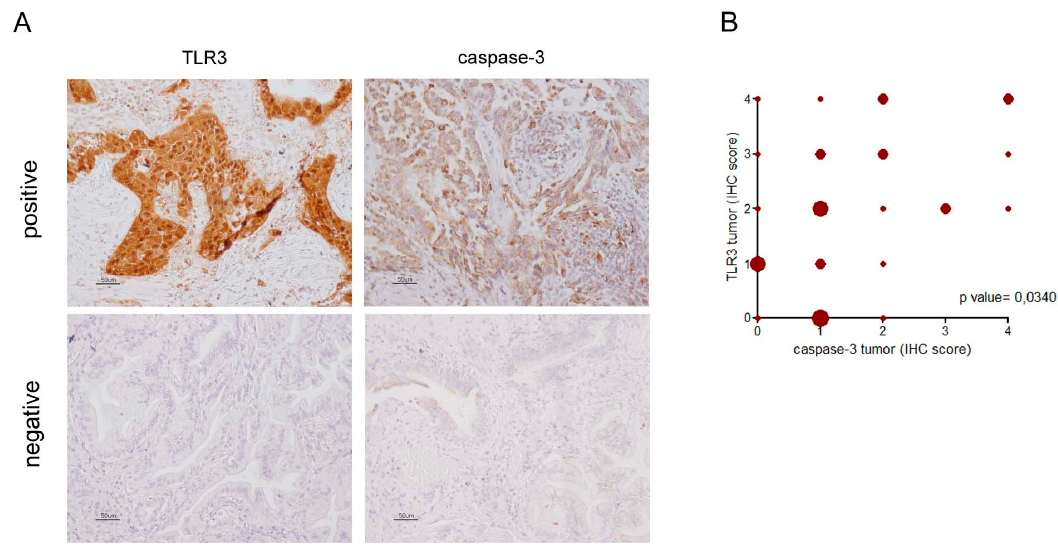
Figure 2. TLR3 and caspase-3 immunohistochemical expression in NSCLC. TLR3 and caspase-3 immunohistochemical staining were performed on FFPE NSCLC sections as described in Materials and Methods. TLR3 and caspase-3 expression was defined as the percentage of positive cells of the total number of cancer cells in the sample in tumor (IHC score: 0 = no positive cells; 1 ≤ 25%; 25% < 2 ≤ 50%; 50% < 3 ≤ 75%; 4 > 75%). ( A ) Images of cases positive and negative both for TLR3 and caspase-3 in the tumor cells. Images are acquired at 20 × magnification. ( B ) Correlation analysis between percentage of IHC-positive cells for TLR3 expression with percentage of IHC-positive cells for caspase-3 expression in the tumor in adenocarcinoma NSCLC ( n = 33; p = 0,0365; Pearson r = 0,3655; 95% confidence interval 0.02532 to 0.6299). Shape size is related to the number of cases represented.